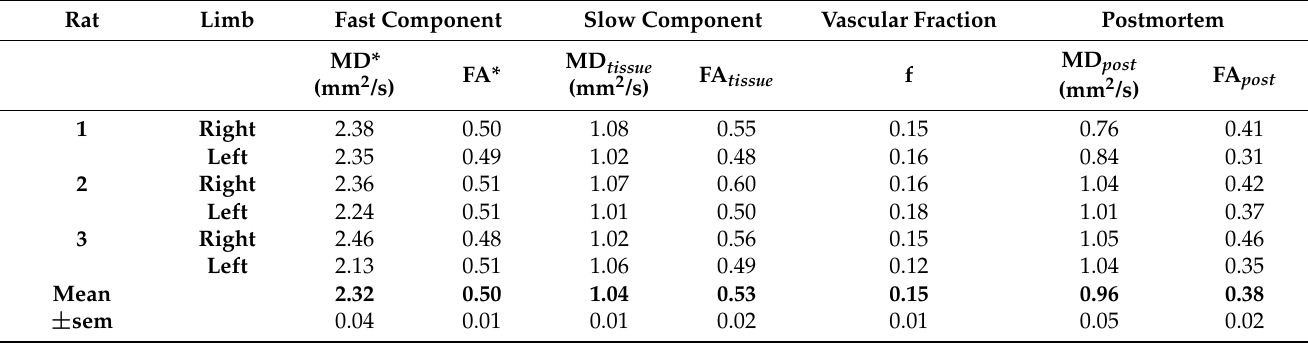
Figure 3. Diffusion orientations of the rat sciatic nerve. The primary eigenvectors of D * (i.e., fast compartment of the in vivo diffusion signal), D tissue (slow compartment of the same), and D post (post- mortem diffusion signal) from two animals (separate rows) are RGB-coded, shown overlaid on their FA maps. The intensities of the images have been scaled to enhance contrast.